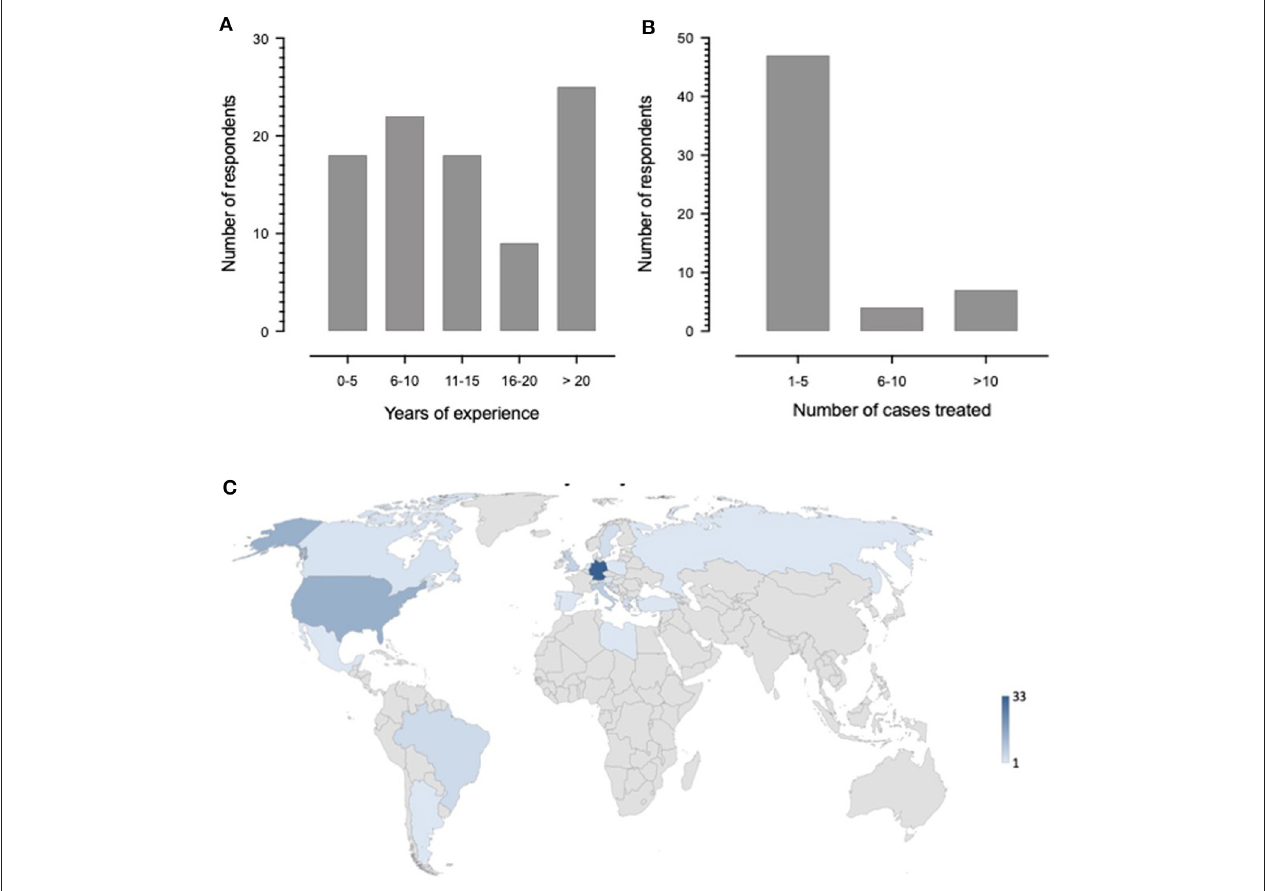
FIGURE 1 | Demographics of participants. (A) Number of years of experience clinicians have working in their subspecialty. (B) Number of patients with p-cPACNS respondents have treated. One of the responders answered to having treated more than 100 cases. (C) Map depicting which countries the respondents work in. The number of respondents from the countries are shown in the legend using a shading scale. The darker shading indicates more responses were from those countries.